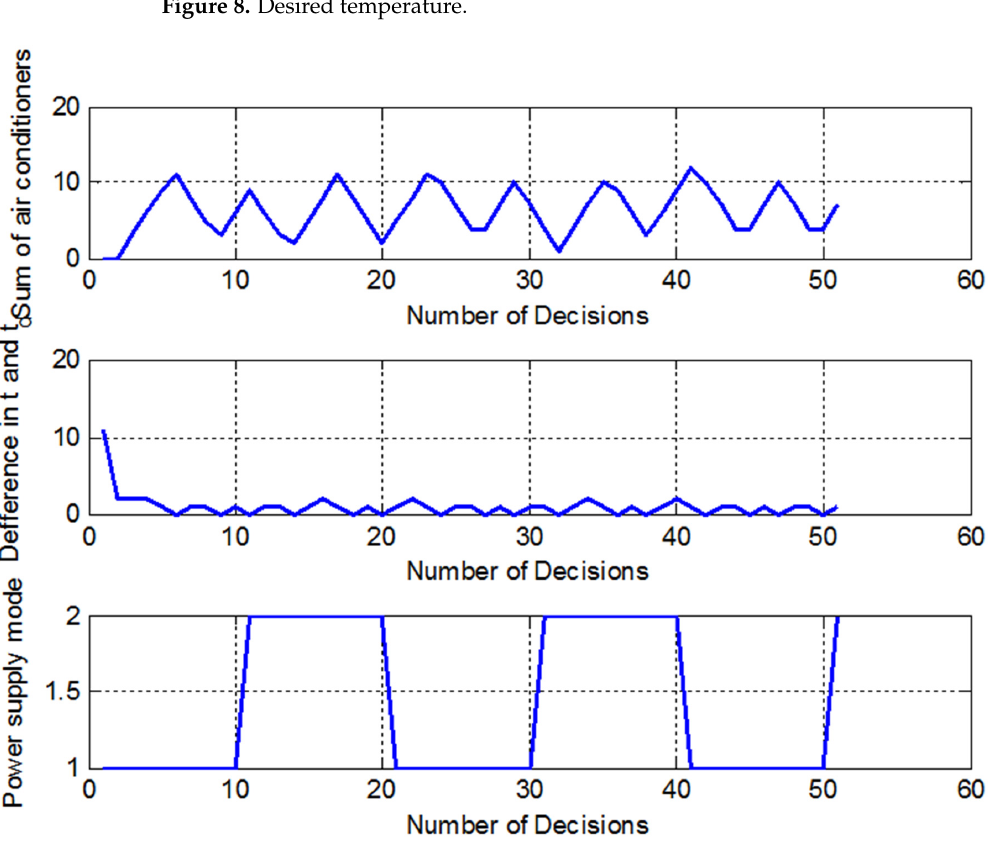
Figure 9. Effect of power